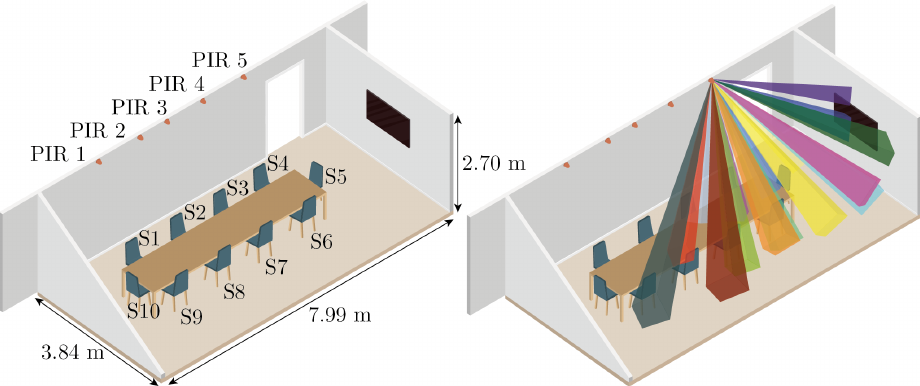
Figure 5. Illustration of the meeting room used during the experiments. The left part of the figure shows the naming convention used when referring to various sensors and seat positions in the room. The right part of the figure illustrates how the beams of one of the PIR sensors spread out into the room. PIR 1–5 indicates the respective position of each of the five passive infrared motion sensors in the room. S1–S10 represents the ten different seat positions in the